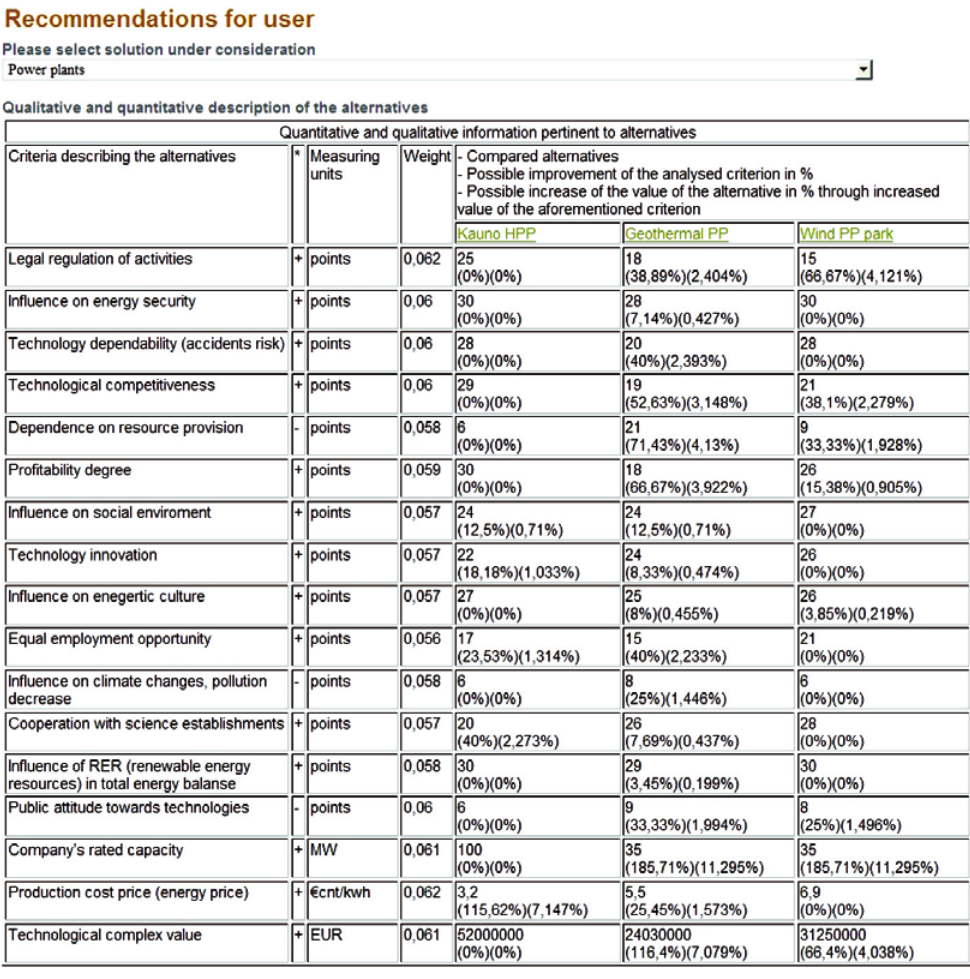
Figure 6. the recommender